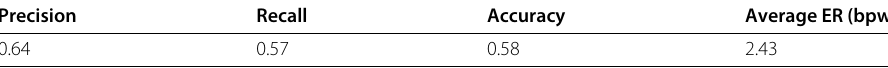
Table 2 Security analysis results in subjective aspect